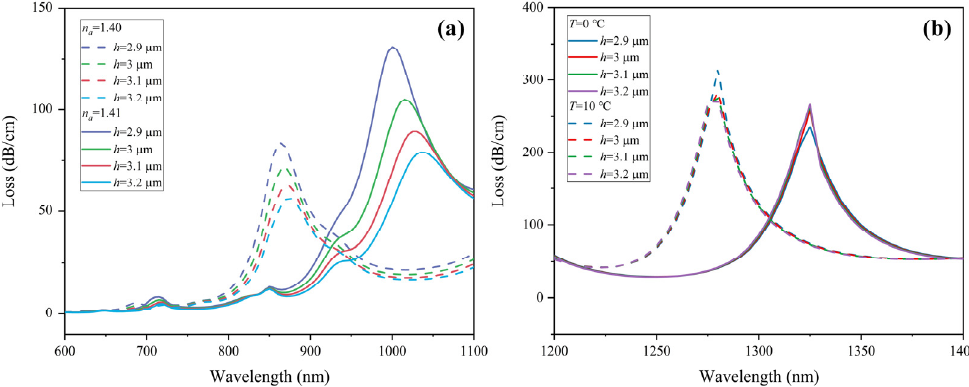
Figure 9. Loss spectra of ( a ) y- polarization core mode in RI sensing channel when analyte RI varies from 1.40 to 1.41, and ( b ) x- polarization core mode in temperature sensing channel under ambient temperatures from 0 to 10 °C with different polishing depths of Au film h .